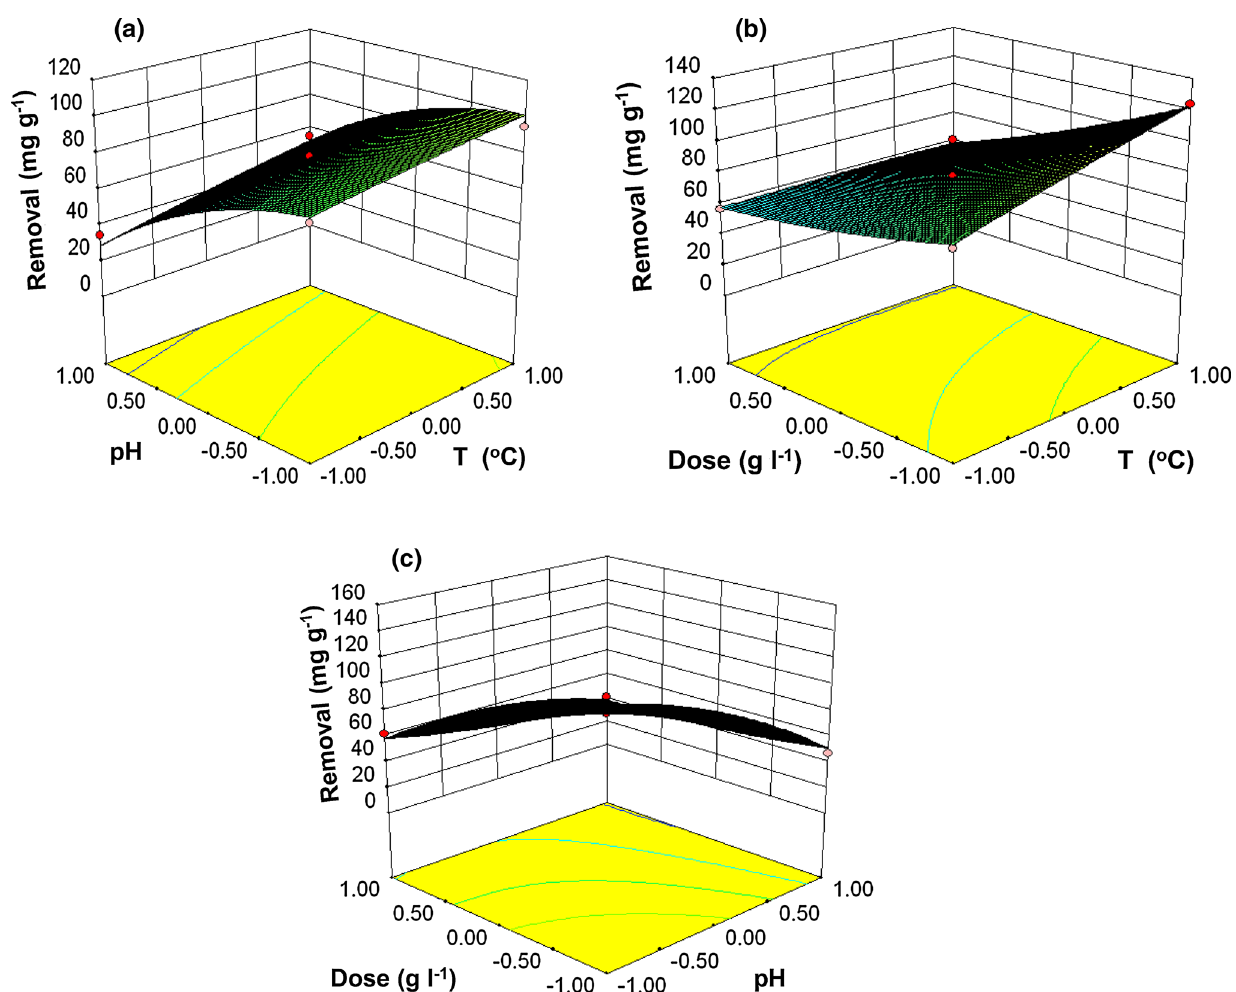
Fig. 5 The response surface plot showing effect of a temperature and solution pH, b temperature and nanoparticles dose, c pH and nanoparticles dose on phosphate removal by